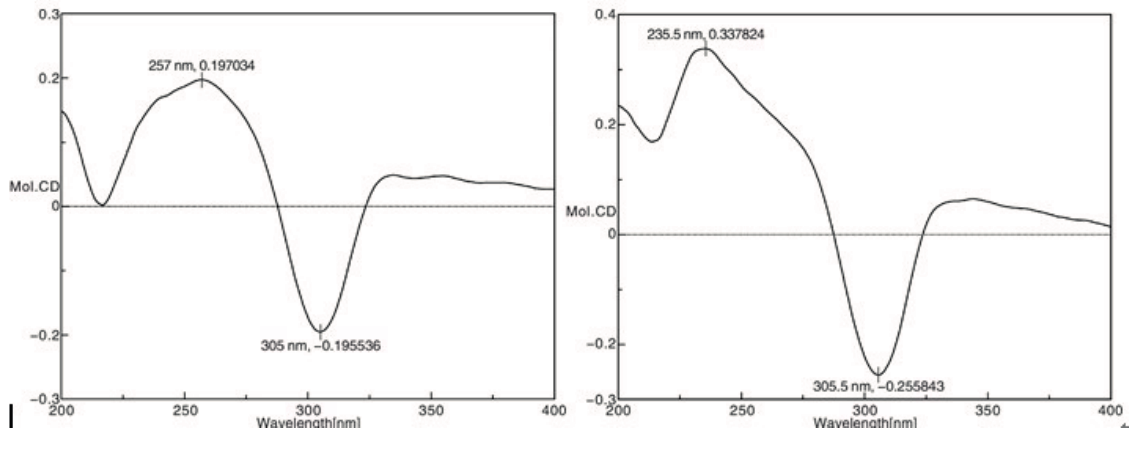
Figure 4. Experimental CD spectra of compounds 1 and 2